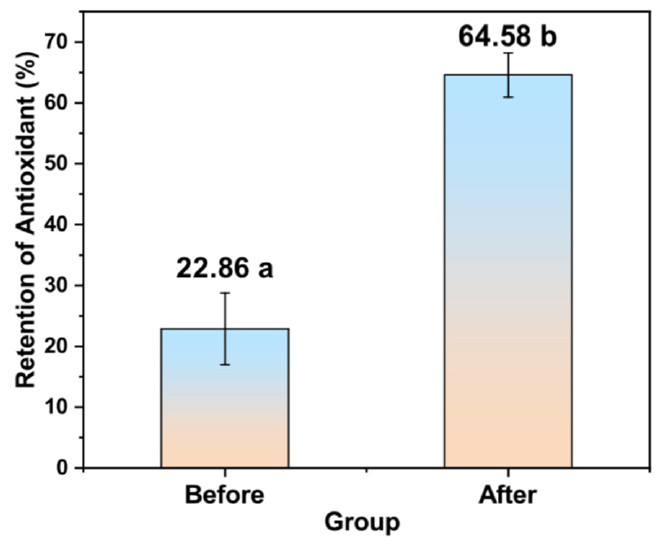
Figure 6. The comparison of antioxidants of MGS before and after embedding in acidic conditions,the letter a and b represents a significant difference between the two groups.